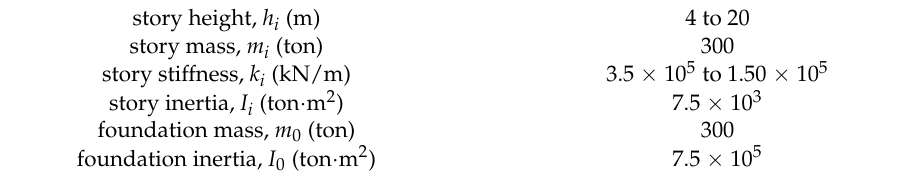
Table 5. Properties of the five-story building.